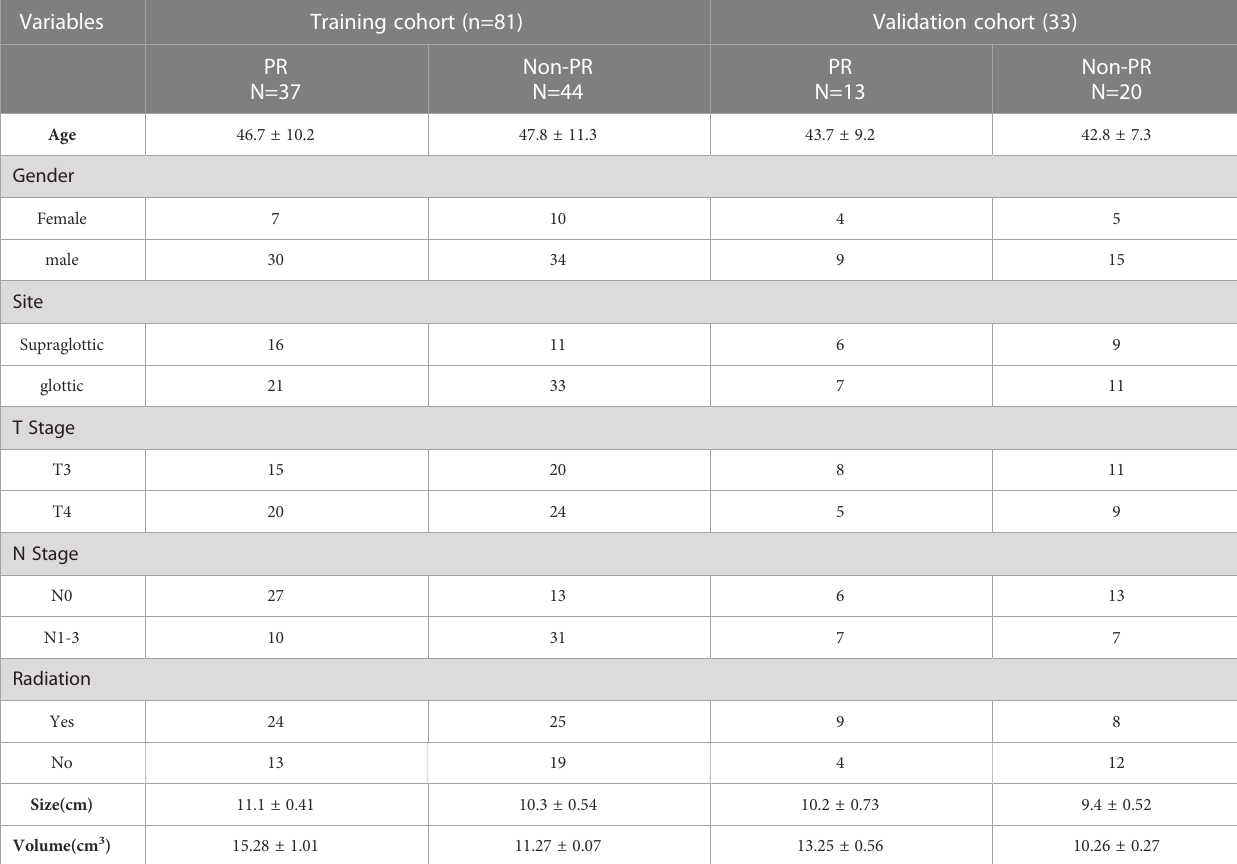
TABLE 1 The clinical and imaging characteristics of primary